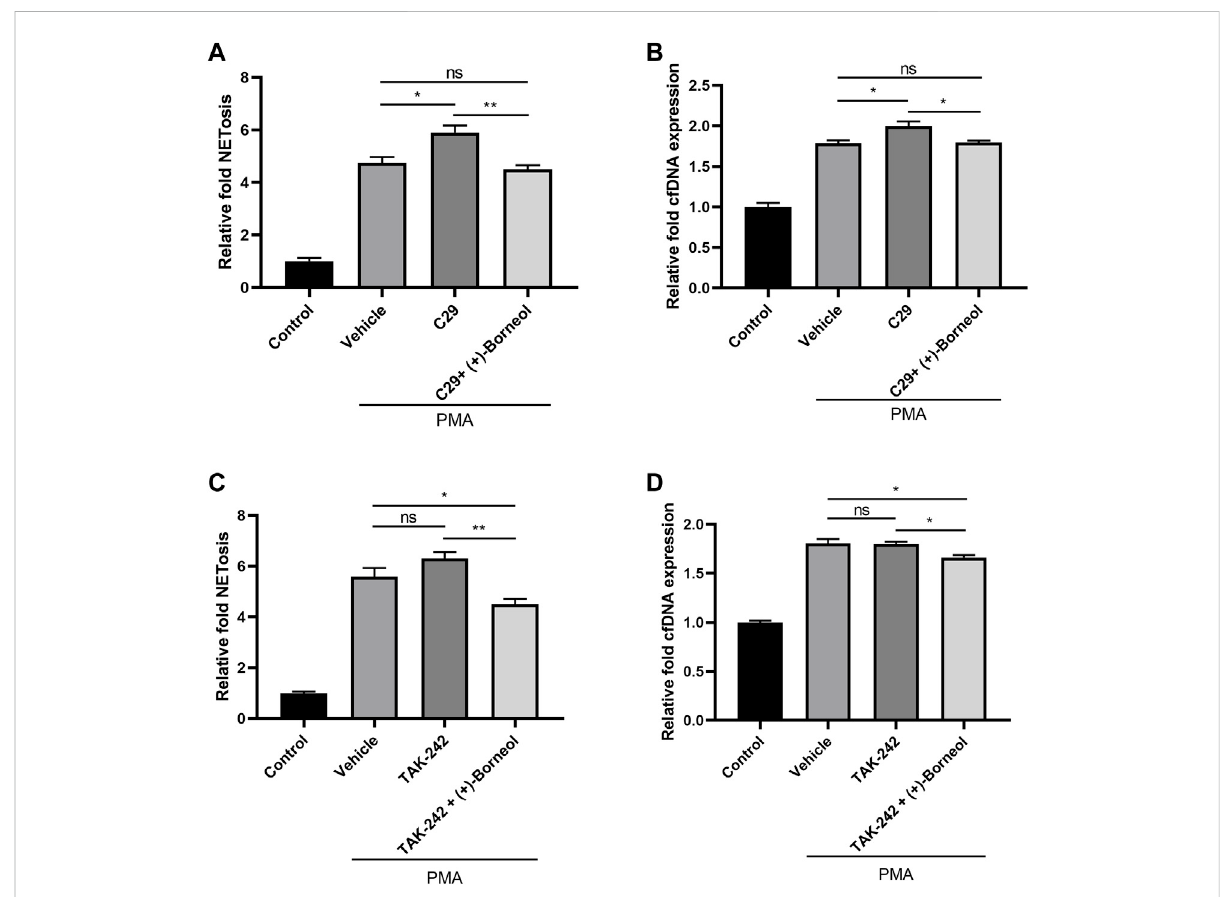
FIGURE 5 (+)-Borneol suppressed NETosis in a way independent of TLR2/4. (A,B) Neutrophils pre-incubated with 100 μ M C29 were treated with or without (+)-borneol and then stimulated with PMA. (A) NETosis and (B) cfDNA were detected after stimulation. (C,D) Neutrophils preincubated with 100 μ MTAK242weretreatedwithorwithout(+)-borneolandthen stimulatedwithPMA. (C) NETosisand (D) cfDNAweredetectedafter stimulation. n = 3 per group; * p < 0.05 and ** p < 0.01; ns = not signi fi